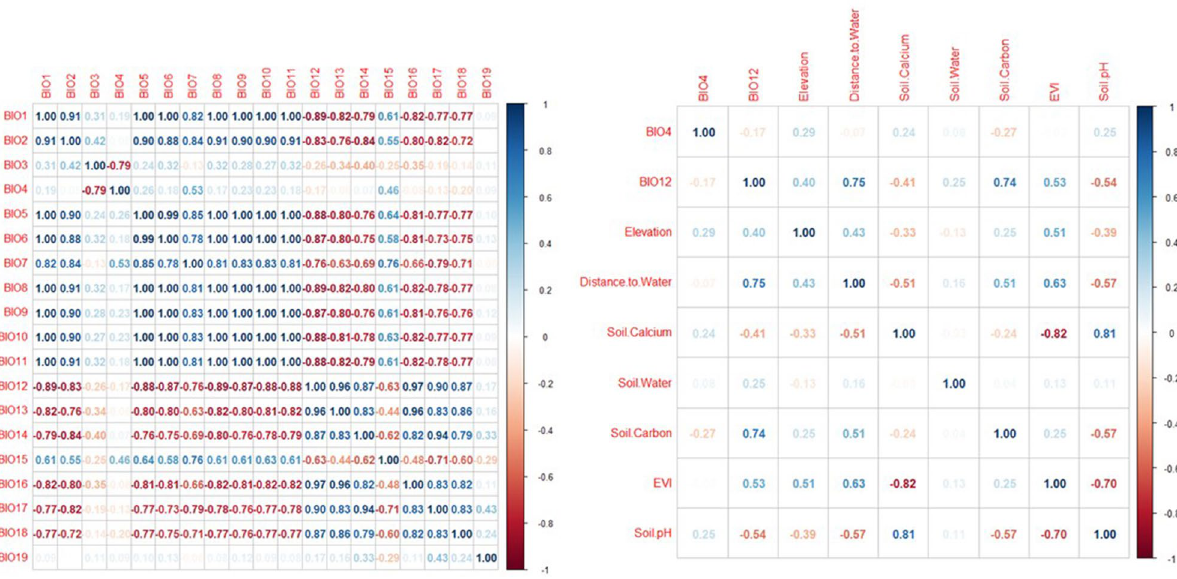
Figure 2. Results of correlation between covariates using Pearson’s correlation test. Correlation between covariates was shown by red numbers (negative correlation) and blue numbers (positive correlation). BIO1 = Annual Mean Temperature, BIO2 = Mean Diurnal Range, BIO3 = Isothermality, BIO4 = Temperature Seasonality, BIO5 = Max Temperature of Warmest Month, BIO6 = Min Temperature of Coldest Month, BIO7 = Temperature Annual Range, BIO8 = Mean Temperature of Wettest Quarter, BIO9 = Mean Temperature of Driest Quarter, BIO10 = Mean Temperature of Warmest Quarter, BIO11 = Mean Temperature of Coldest Quarter, BIO12 = Annual Precipitation, BIO13 = Precipitation of Wettest Month, BIO14 = Precipitation of Driest Month, BIO15 = Precipitation Seasonality, BIO16 = Precipitation of Wettest Quarter, BIO17 = Precipitation of Driest Quarter, BIO18 = Precipitation of Warmest Quarter, BIO19 = Precipitation of Coldest